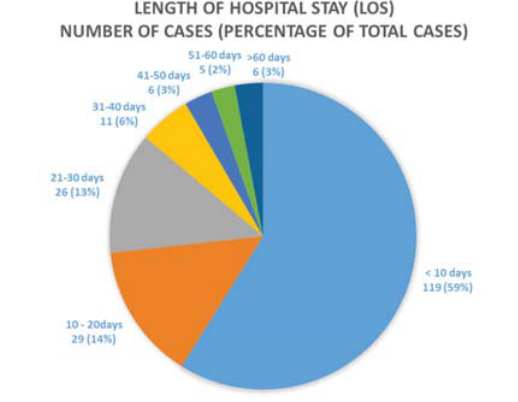
Figure 14. Patient distribution according to Length of Hospital stay (LOS) The median hospital stay was eight days (range 1-120 days). Median length of hospital stay per percent burn was, (cid:75)(cid:82)(cid:90)(cid:72)(cid:89)(cid:72)(cid:85)(cid:15)(cid:3)(cid:81)(cid:82)(cid:87)(cid:3)(cid:86)(cid:87)(cid:68)(cid:87)(cid:76)(cid:86)(cid:87)(cid:76)(cid:70)(cid:68)(cid:79)(cid:79)(cid:92)(cid:3)(cid:71)(cid:76)(cid:3445)(cid:72)(cid:85)(cid:72)(cid:81)(cid:87)(cid:3)(cid:76)(cid:81)(cid:3)(cid:73)(cid:72)(cid:80)(cid:68)(cid:79)(cid:72)(cid:86)(cid:3)(cid:68)(cid:86)(cid:3)(cid:70)(cid:82)(cid:80)(cid:83)(cid:68)(cid:85)(cid:72)(cid:71)(cid:3) to males (0.5 days for females and 0.6 days for